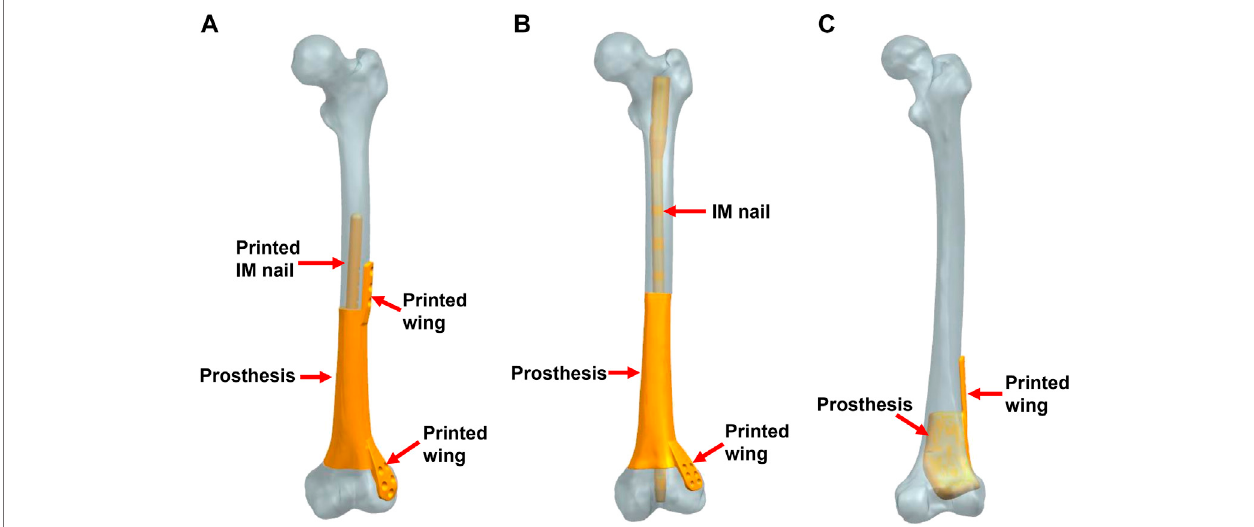
FIGURE 2 | Three fi xation modes of different prostheses (IM: intramedullary). (A) Mode I, the integral prosthesis with printed IM nail and wings; (B) Mode II, the integral prosthesis with one printed wing; (C) Mode III, the integral prosthesis with one printed wing.